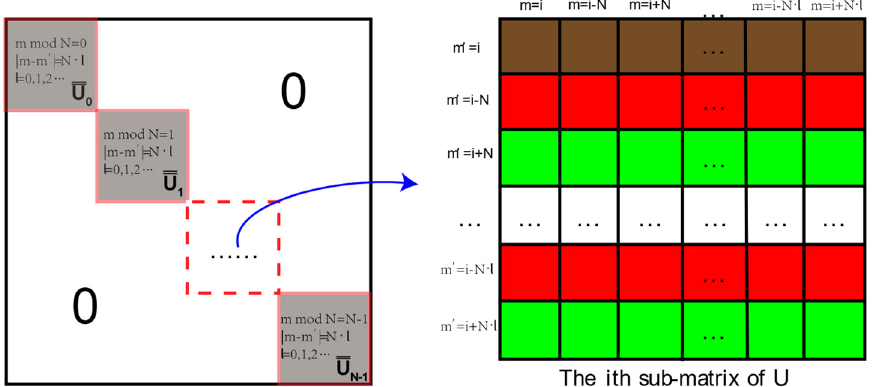
Figure 4. The layout of the matrix element of U matrix. Because of the symmetrical properties of U matrix, it can be rearranged as a block diagonal matrix with N blocks. Different colors correspond to different azimuth mode “ m (cid:48) ”, brown indicates m (cid:48) = i , red and green indicate increase and decrease on this basis respectively.